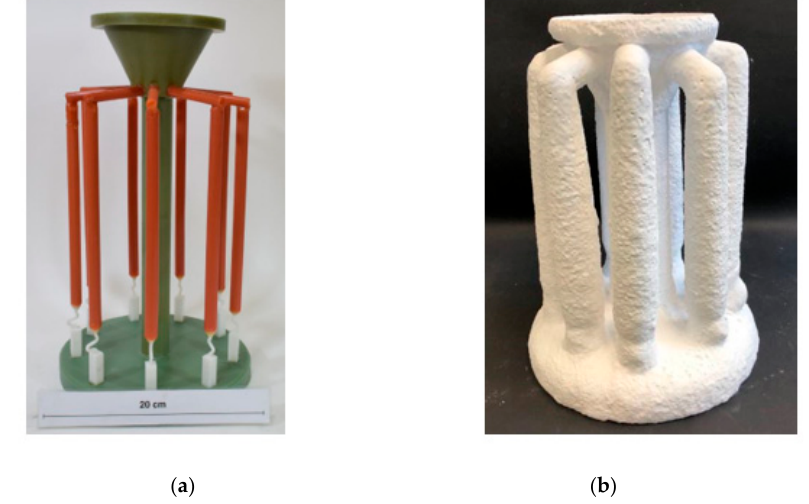
Figure 2. Images of the wax model ( a ) and the shell mold ( b ).